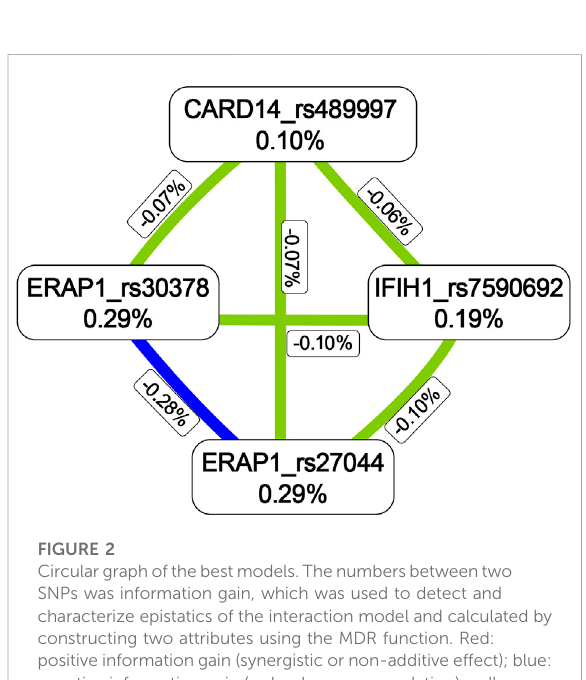
FIGURE 1 High-andlow-risk genotypesinthebestpsoriasisinteraction model. Dark-gray cells represent high risk (combinations exceeding the r ratio of the percentage of cases to controls ≥ 1.0) and light-gray cells represent low risk (combinations below the ratio threshold).